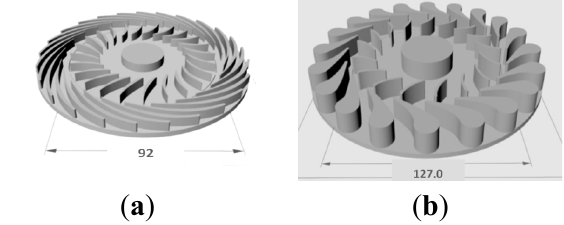
Figure 1. ( a ) 3-D sketch reference geometry for ultra micro gas turbine generator (UMGTG) compressor, where D e = 92.0 mm [11,13]; ( b ) reference geometry for turbine, D e = 127.0 mm